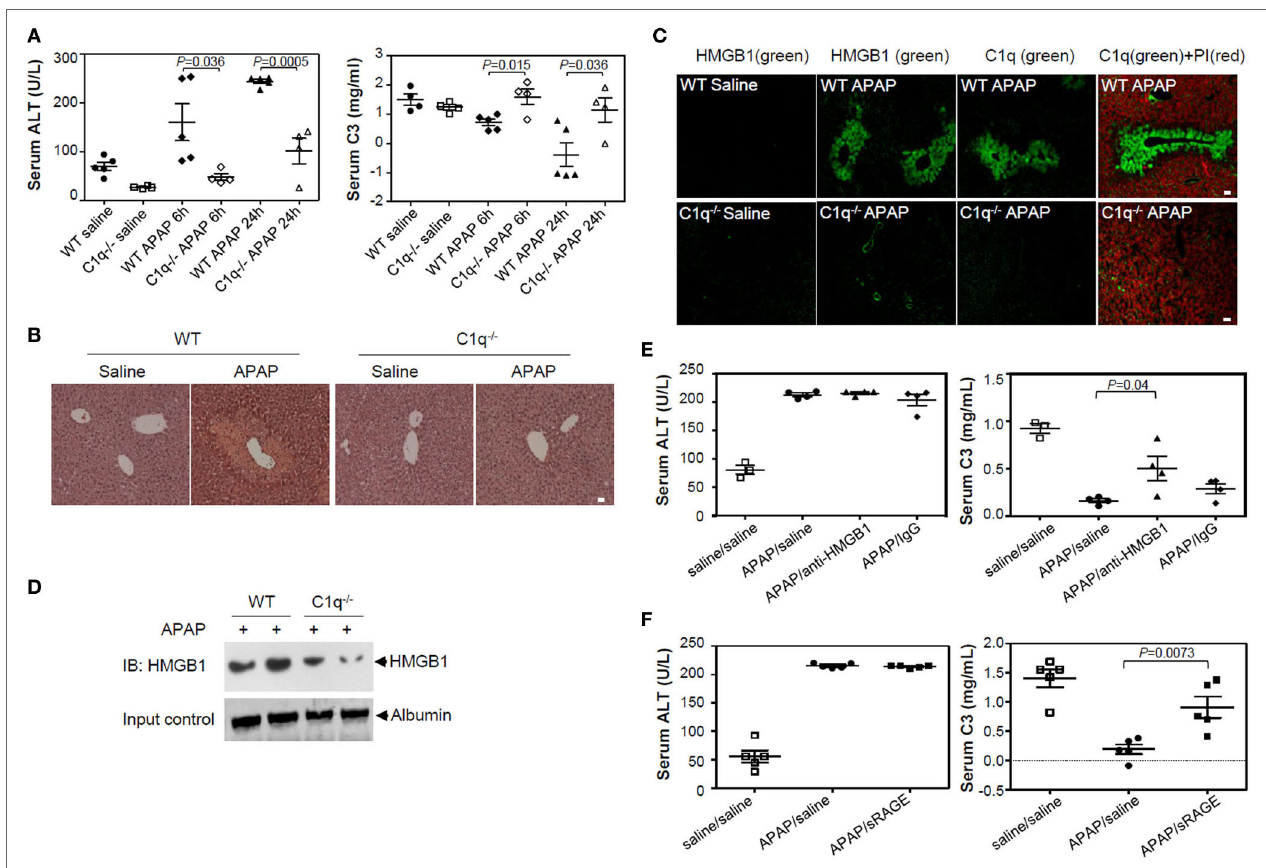
FigUre 6 | High-mobility group box 1 (HMGB1)-induced complement activation is decreased in C1q-deficient mice of APAP-induced hepatotoxicity model. (a) Overnight fasted wild-type (WT) or C1q − / − mice (9–10 weeks old, male) were intraperitoneally (i.p.) treated with 400 mg/kg of APAP or saline. After 0, 6, and 24 h, mouse serum samples were collected. Serum alanine aminotransferase (ALT) activity (left) and C3 levels (right) were determined using ALT color endpoint assay and enzyme-linked immunosorbent assay, respectively. Each dot represents each mouse with triplicates per sample (four or five mice per group). (B,c) Mice were euthanized 24 h after APAP administration, and the left medial lobe of liver was fixed in 4% paraformaldehyde and 30% sucrose. Liver tissue was stained with hematoxylin and eosin for evaluation of necrosis and hemorrhage (B) . Tissue-Tec OCT-embedded liver was stained with anti-C1q and anti-HMGB1 antibodies (Abs) for immunofluorescence analysis (c) . (D) Serum HMGB1 protein from WT and C1q − / − mice was detected using Western blot analysis 24 h after APAP injection. (e) Anti-HMGB1 (2G7) or mouse IgG (5 μ g/mouse) was i.p. administrated immediately after APAP administration to block HMGB1. After 24 h, mouse serum samples were collected and ALT activity (left panel) and concentration of C3 (right panel) were determined. Saline was used as a negative control. (F) HMGB1 was i.p. injected with sRAGE (5 µg/mouse) as described in (e) . N = 4–5 mice/group. Data = mean ± SEM. Student’s t -test (unpaired two-tailed) was used to calculate the P -value. All scale bars, 20 µm. Data are representative of three (a–e) or two (F) independent